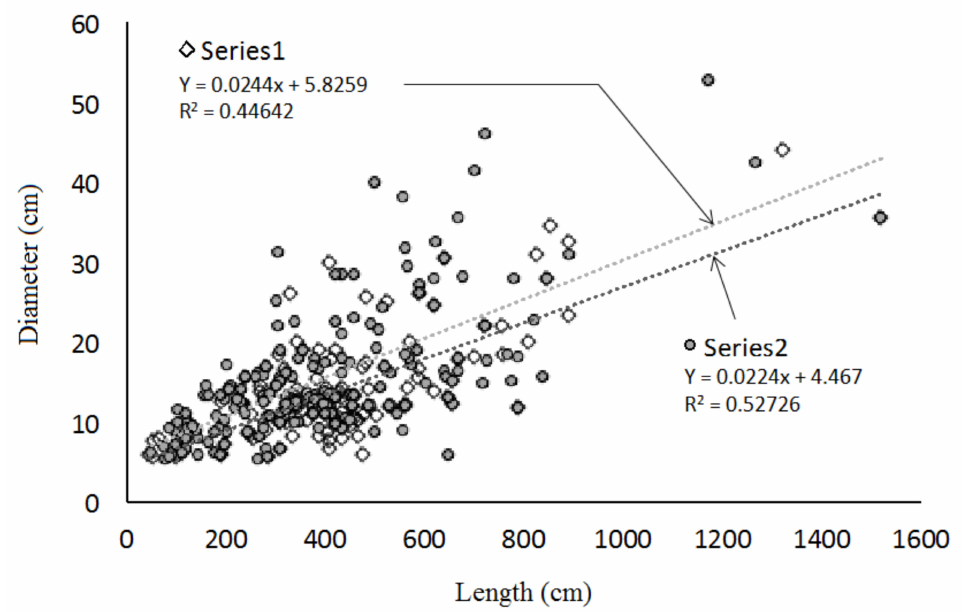
Figure 2. Relationship between length and diameter of large wood (LW) as measured during field surveys of in-stream LW at Site 1 at Ellicott Creek (Series 1, 1.5 km-long stream section, n = 134) and at Site 2 at Murder Creek (Series 2, 1.5 km-long stream section, n =